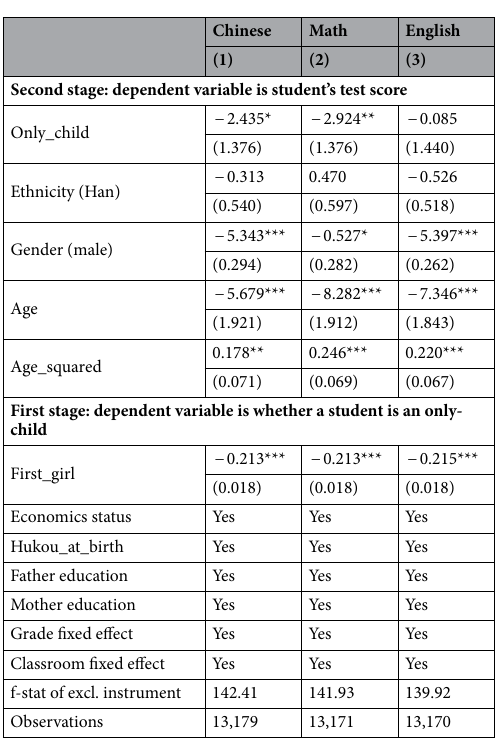
Table 7. The IV estimation of the effect of only-child status on standardized test scores. Notes: Standard errors in parentheses, adjusted for within-classroom clustering. * p < 0.10. ** p < 0.05. *** p <